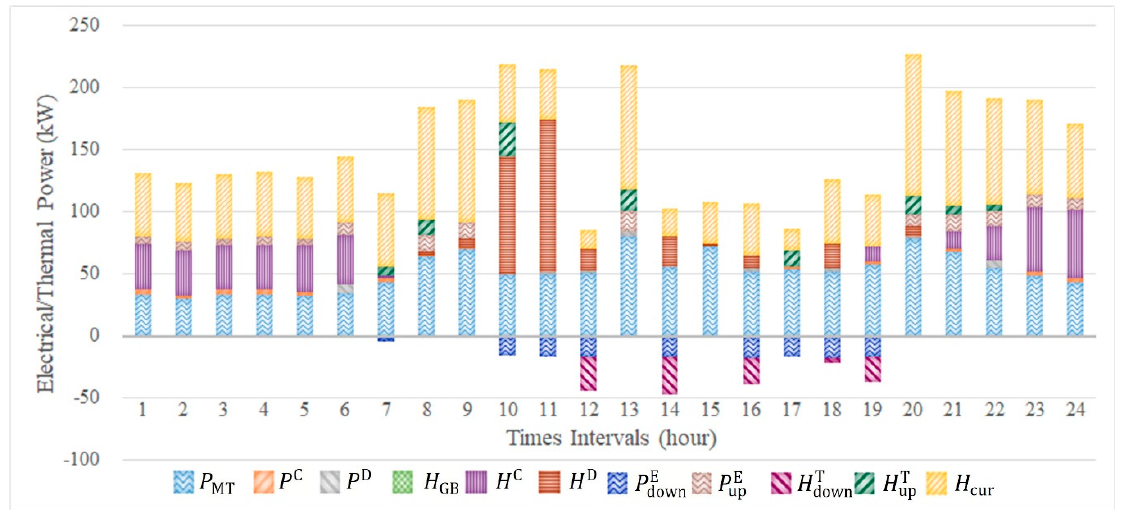
Figure 10. The optimal operation results in Case 5 on the typical winter day. Note: the H cur in the above figure means the amounts of thermal power